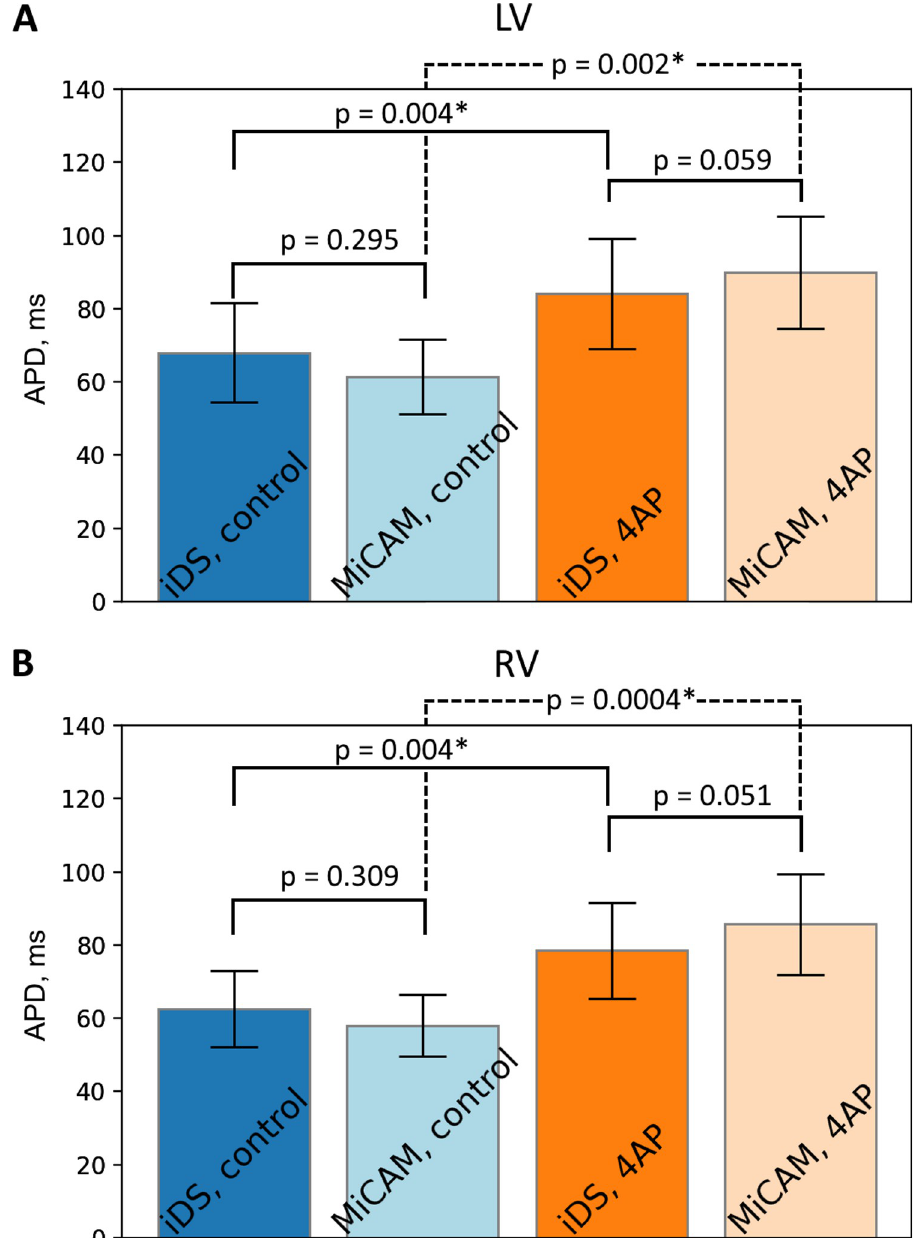
Fig 5. Comparison of APD measured by iDS and MiCAM. (A) Comparison of APD in left ventricle. (B) Comparison of APD in right ventricle. Comparison was made for a range of hearts (n = 6) at PCL = 150ms in control and in presence of 5.6mM 4AP. Statistically significant differences are marked by an asterisk (paired t-test).